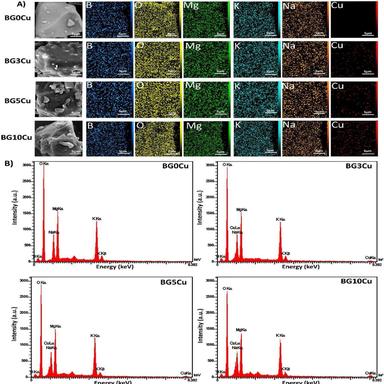
(A) An energy-dispersive X-ray spectroscopy mapping analysis confirmed that B, O, Mg, K, Na, and Cu were distributed uniformly in each particle of the modified bioactive glasses. (B) An energy-dispersive X-ray spectroscopy spectrum of the modified bioactive glasses showed that their composition was quite in line with the theoretical value.